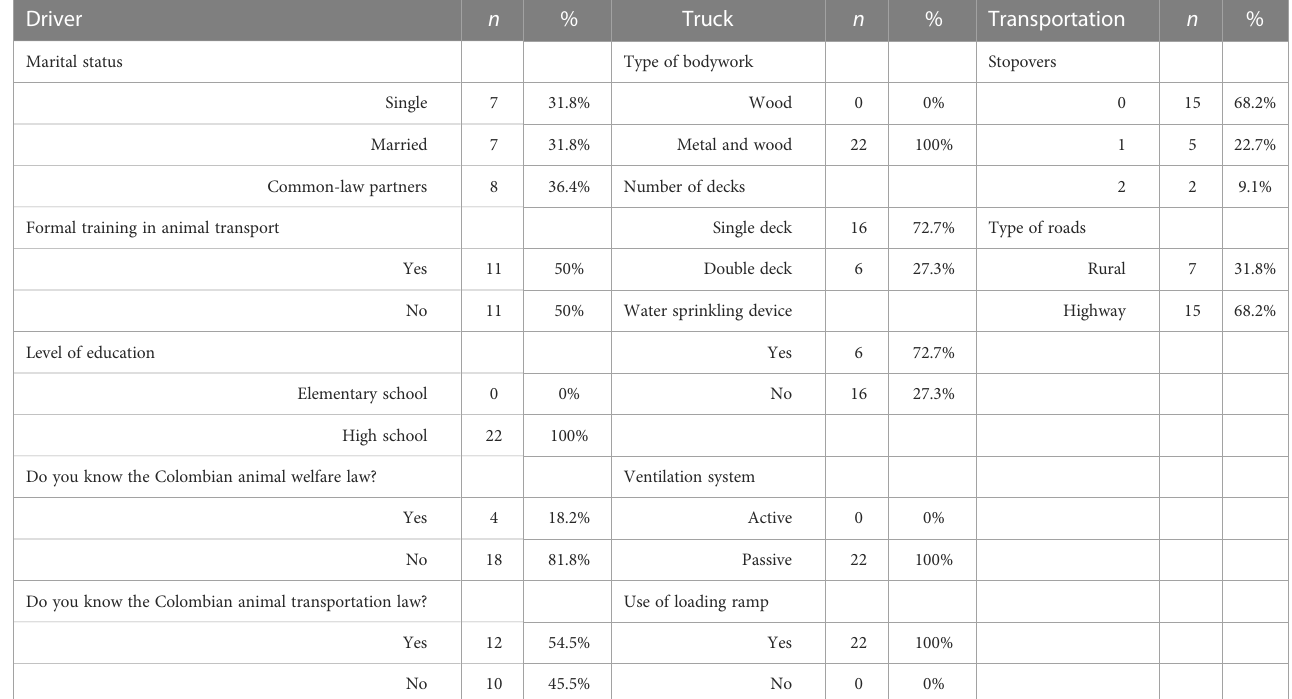
TABLE 2 Percentage of responses characterizing sociodemographic variables of the driver (i.e., marital status, training in animal transport, level of education, knowledge of Colombian animal welfare law, and animal transportation law), truck (i.e., type of bodywork, number of decks, water sprinkling device, ventilation system, and use of loading ramp), and transportation (i.e., stopovers, and type of roads), as estimated by descriptive statistics. Driver n